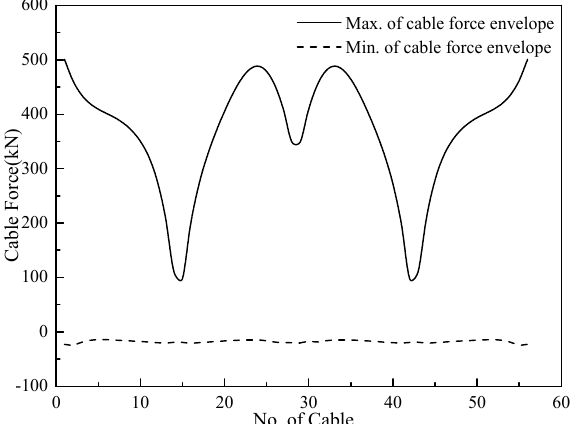
Figure 2. Envelope diagram of cable force.